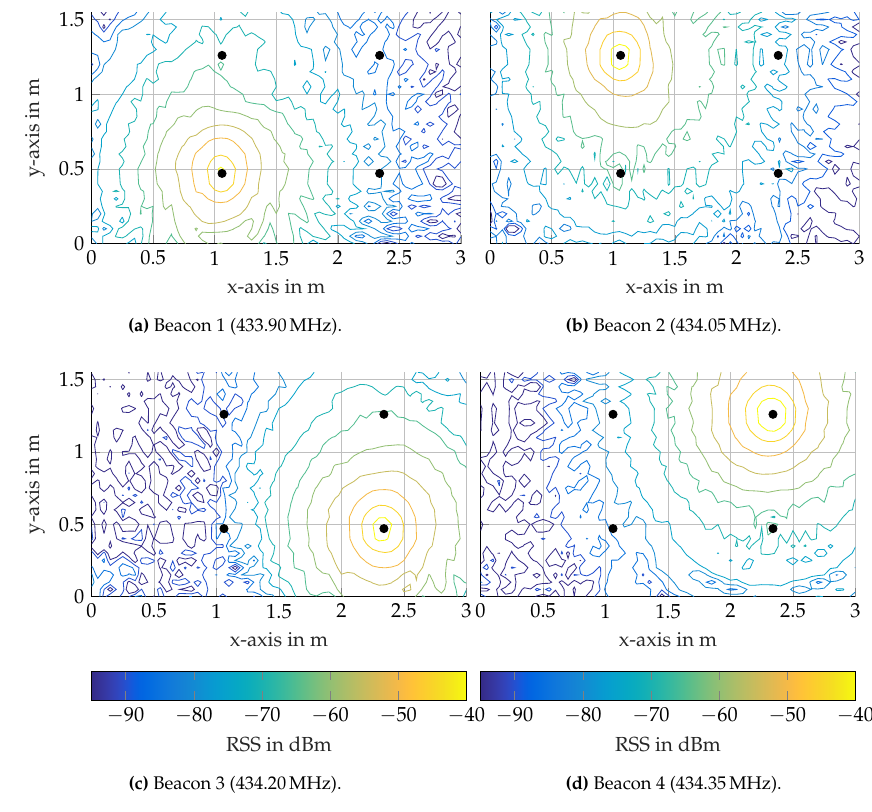
Figure 15. Contour plots of RSS values measured over 5 s on each grid point at the beacons’ frequencies. Black markers depict the beacons.